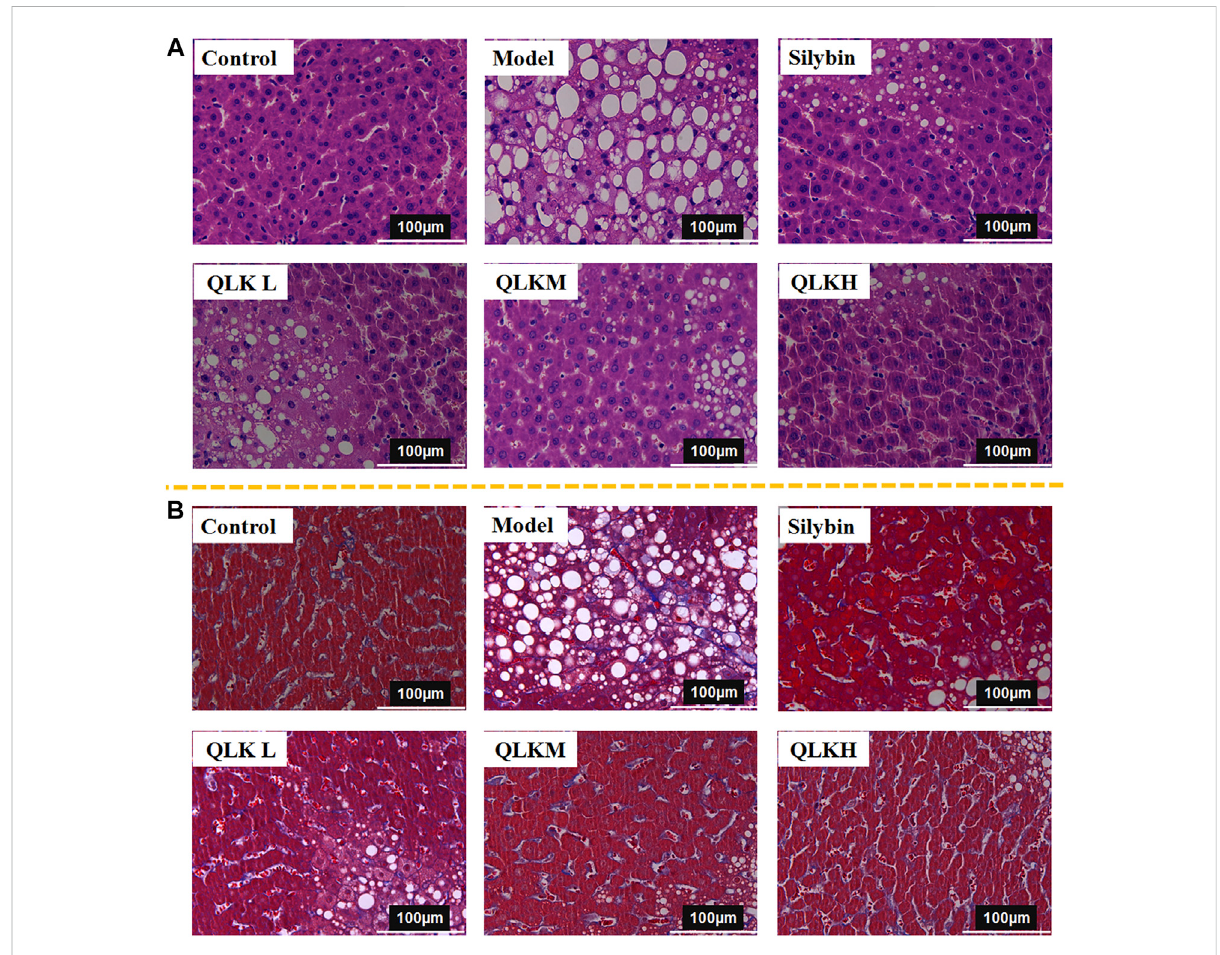
FIGURE 6 Histological analysis. (A) Hematoxylin and eosin (H&E)-stained sections of the liver. Original magni fi cation × 40. (B) Masson-stained sections of the liver. Original magni fi cation ×